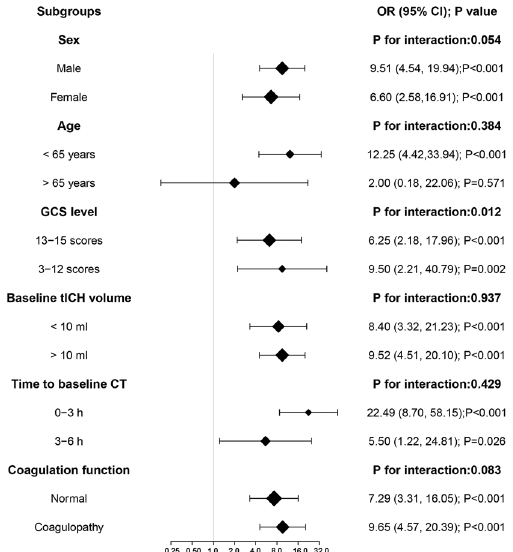
Figure 4. OR (95% CI) for acute tICH expansion in subgroups of cerebral contusion patients and interaction test of stratification factors and the multihematoma fuzzy sign in the matched cohort.